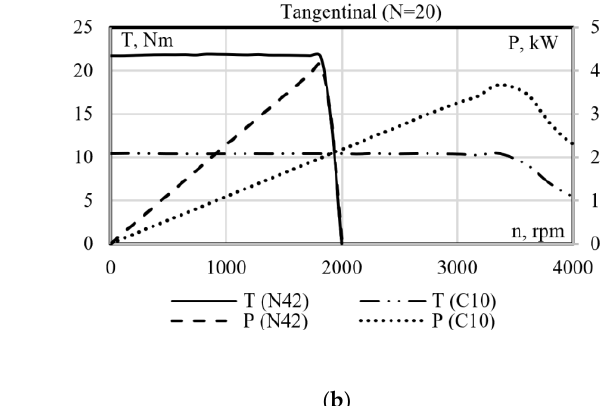
Figure 3. Electromechanical characteristics of the tangential and radial machines with N42 and C10 PMs for N = 90 turns. Here, the X -axis defines the speed of the machines and the Y -axis shows the torque and output power.